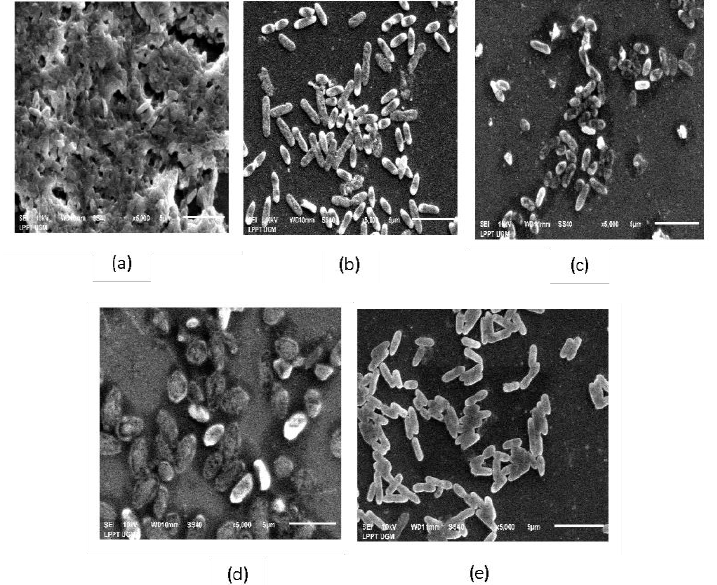
Figure 10. Pseudomonas aeruginosa biofilm on glass coverslips was monitored using a scanning electron microscope with a magnification of × 5000: ( a ) control (untreated) cells, ( b ) treated with L-tartaric acid (TLA), ( c ) glucaric acid (GA), ( d ) D-sorbitol (DS), and ( e ) ascorbic acid (AA).